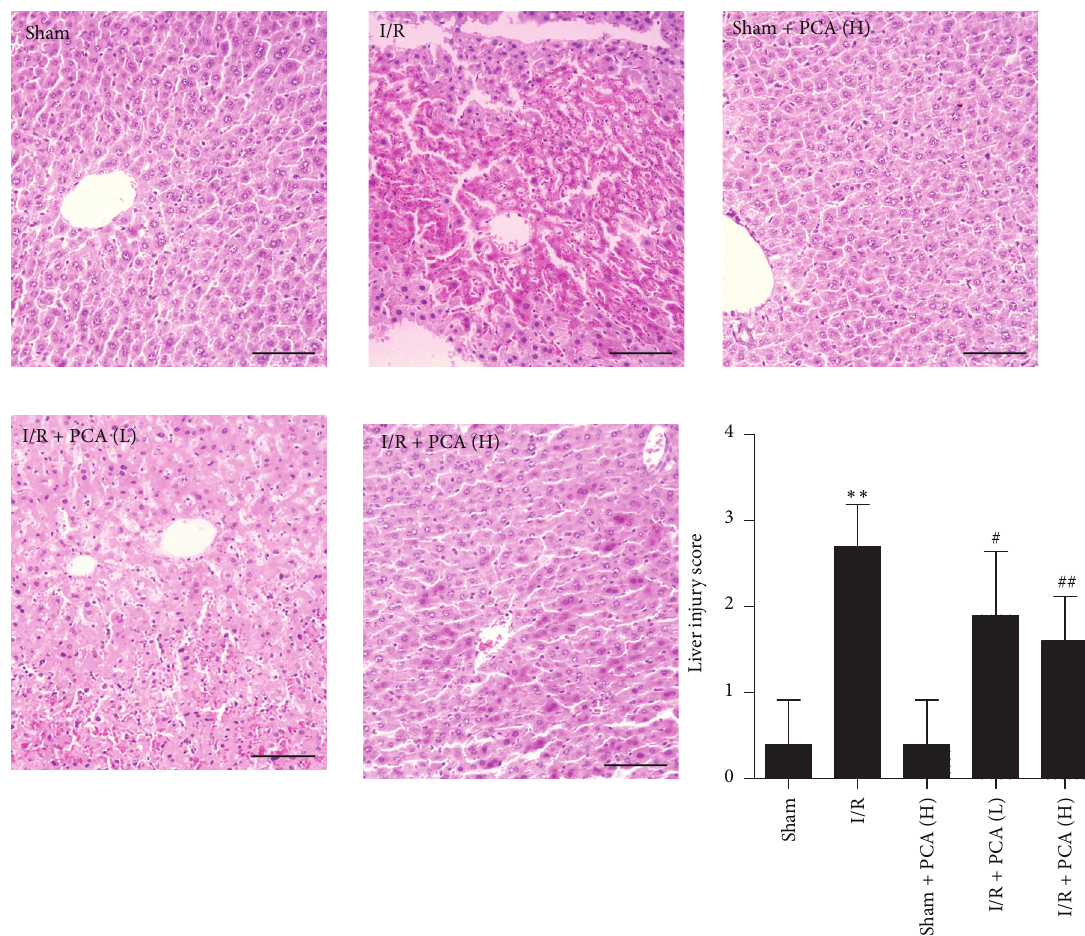
Figure 2: PCA pretreatment improved intestinal I/R-induced liver histopathologic injury. Tissues were harvested at the end of reperfusion and were stained with hematoxylin eosin. Slides were examined under light microscopy at 200x magnification, bars = 50 𝜇 m. Histologic injury scores in groups were quantified. Results are presented as the mean ± SD, 𝑛 = 10 . ∗∗ 𝑃 < 0.01 versus sham group; # 𝑃 < 0.05 versus I/R group; ## 𝑃 < 0.01 versus I/R